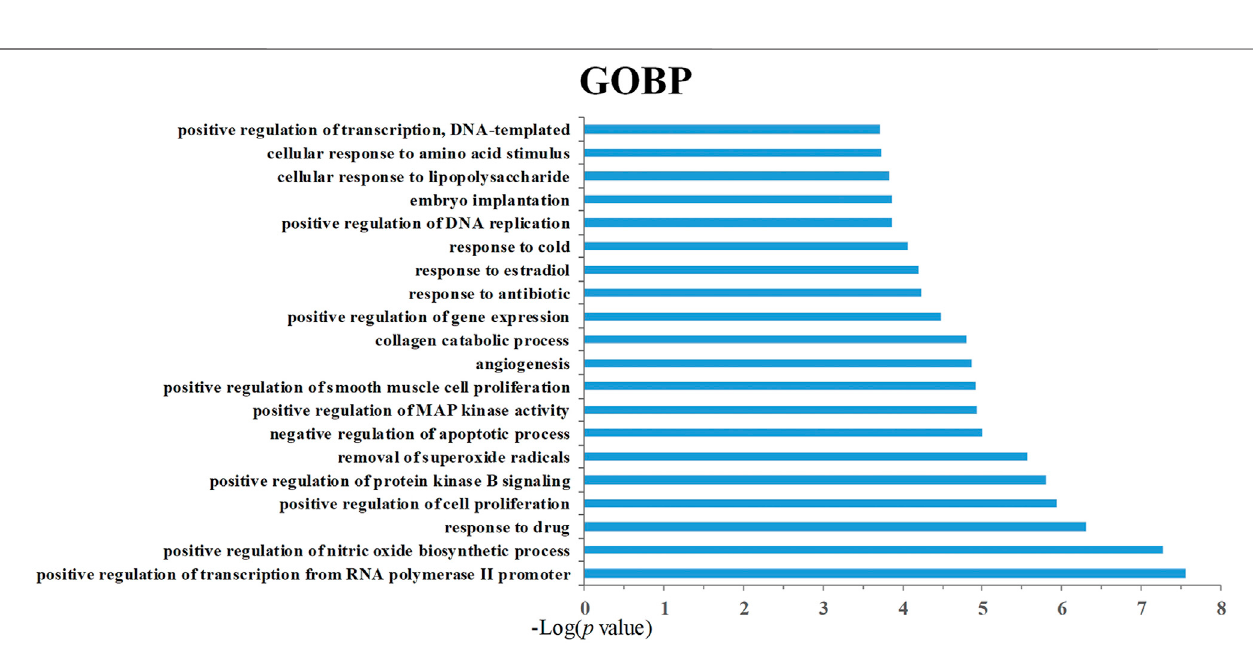
Frontiers in Pharmacology |